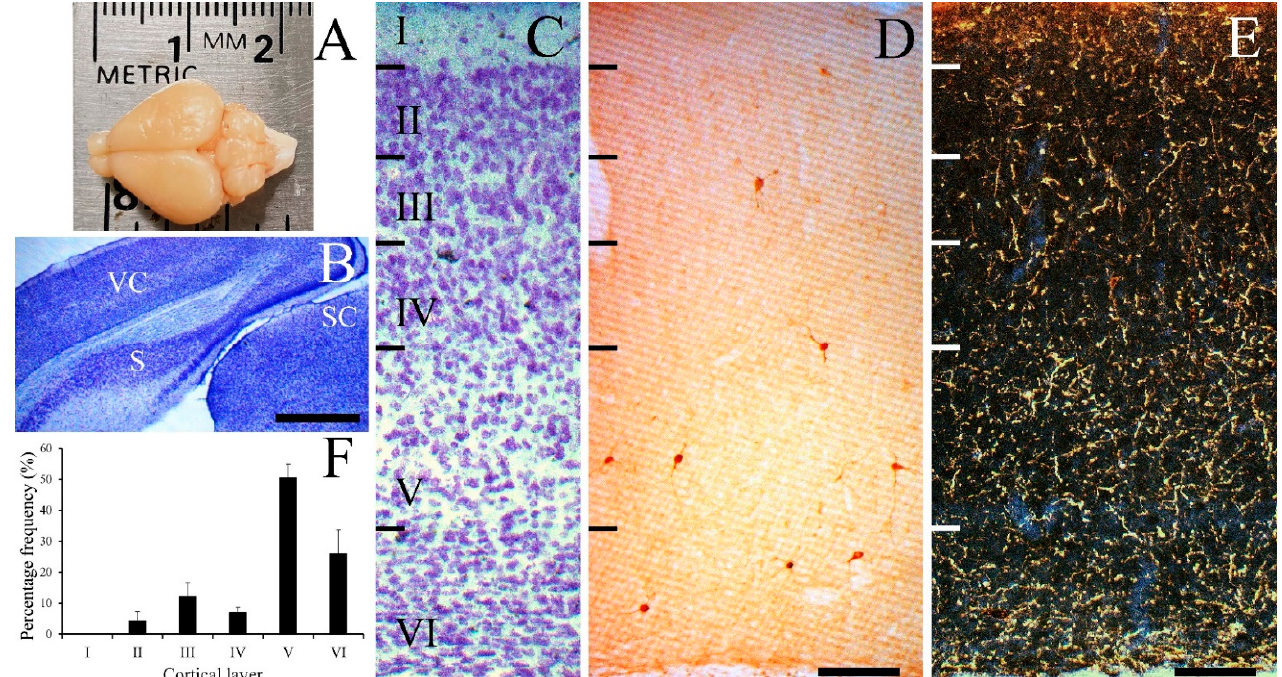
Figure 1. Laminar distribution of NPY-IR neurons with low-power photomicrographs in the gerbil visual cortex. Image of the gerbil brain in dorsal view ( A ) and low-power image of thionin stained gerbil visual cortex and surrounding areas ( B ). Thionin-stained section illustrating cortical lamination ( C ) and NPY-IR neurons ( D ). ( E ) Low-magnification dark-field photomicrograph of the gerbil visual cortex showing well-labeled NPY-IR fibers. ( F ) Histogram of the distribution of NPY-IR neurons in the gerbil visual cortex. NPY-IR neurons were mostly distributed in layers V and VI, but not in layer I. S, subiculum; SC, superior colliculus; VC, visual cortex. Scale bar = 1000 μ m ( B ), and 100 μ m ( D , E ).